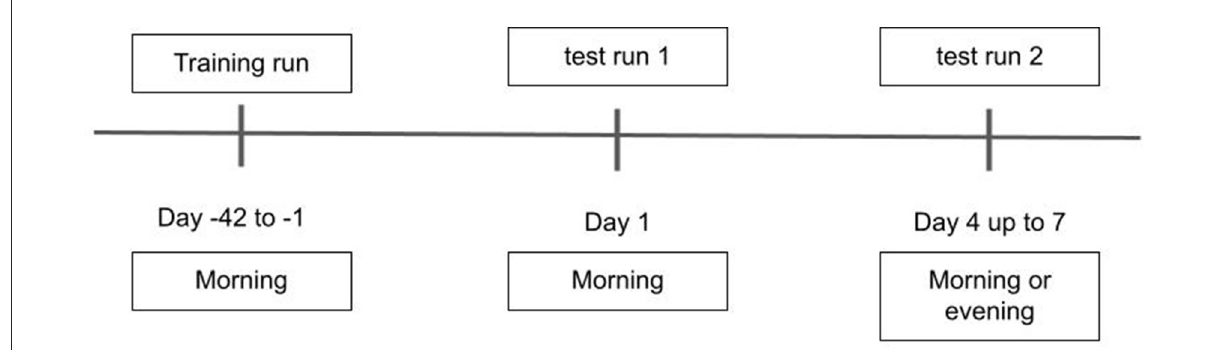
FIGURE1 Baseline assessments and timepoints for the administration of the DNS